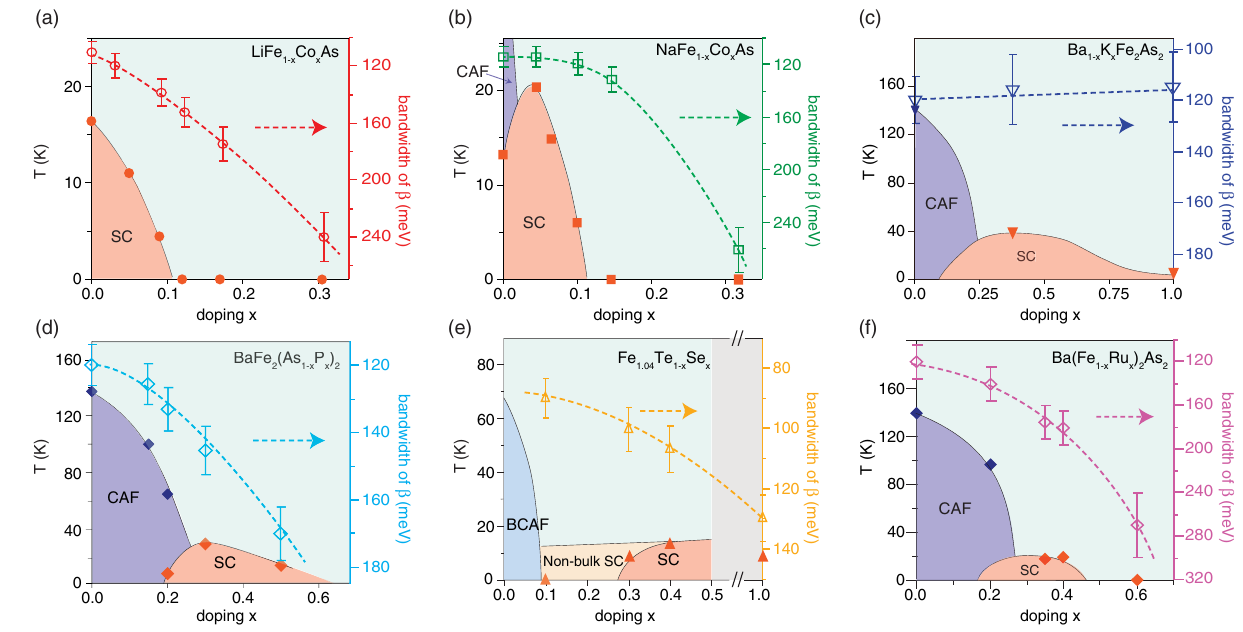
FIG. 4. (a) Evolutions of T C and β bandwidths with doping in LiFe 1 − x Co x As. Panels (b) – (f) are the same as (a), but for NaFe 1 − x Co x As, Ba 1 − x K x Fe 2 As 2 , BaFe 2 ð As 1 − x P x Þ 2 , Fe 1 Te 1 − x Se x , and Ba ð Fe 1 − x Ru x Þ 2 As 2 , respectively. The superconducting, . 04 collinear antiferromagnetic, and bicollinear antiferromagnetic phases are abbreviated as SC, CAF, and BCAF, respectively. The bandwidth for Fe 1 Se in panel (e) was extracted from Refs. [38,39]. Note that the doping range for 0 . 5 < x < 1 . 0 in Fe 1 . 04 cannot be chemically synthesized [40]. The phase diagrams for Ba 1 − x K x Fe 2 As 2 , BaFe 2 ð As 1 − x P x Þ 2 , Fe 1 Ba ð Fe 1 − x Ru x Þ 2 As 2 were extracted from Refs. [9,10,12,41]. The error bars of β bandwidths come from the uncertainty in the dispersion